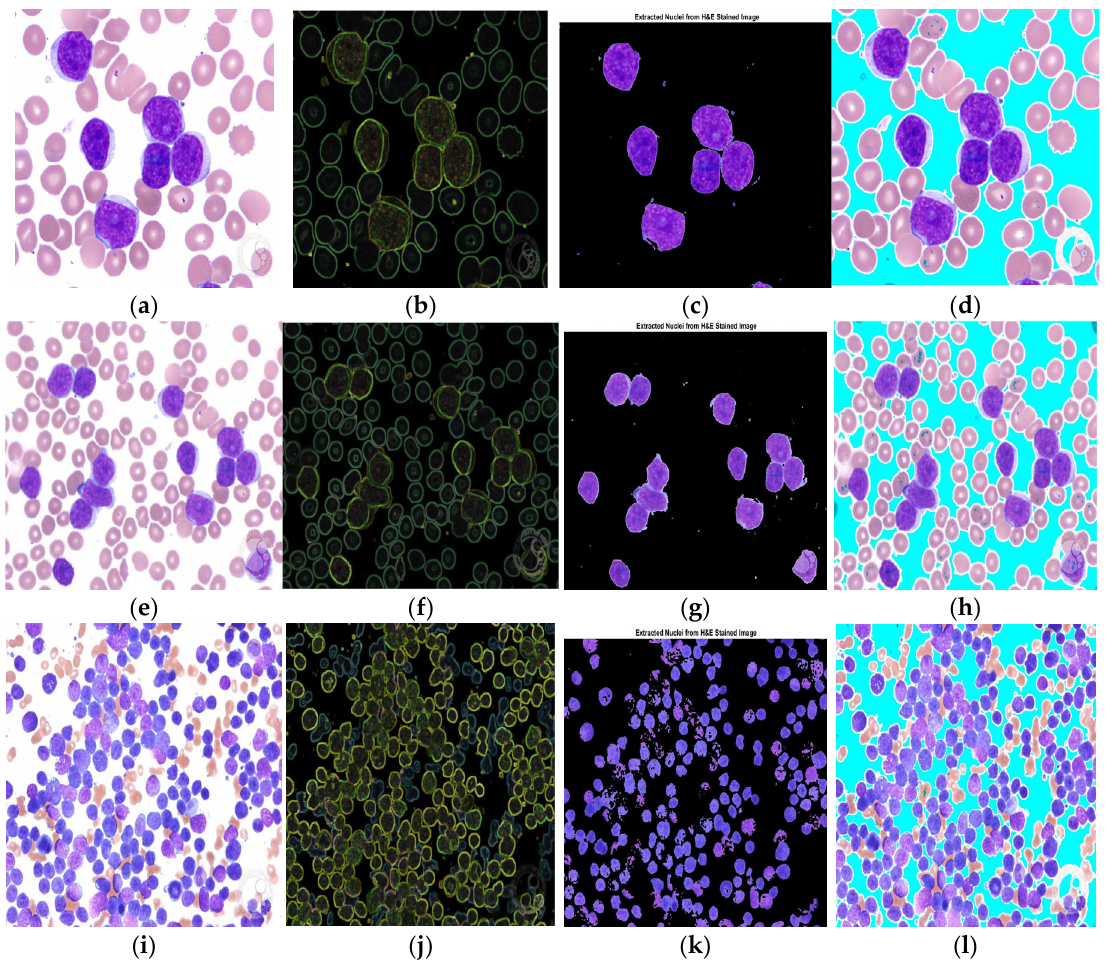
Figure 7. Output of L*a*b* projected k-means clustering (K = 3) algorithm. ( a , e , i ) Input Images ( b , f , j ) Different hue levels ( c , g , k ) Isolation of nuclei ( d , h , l ) Clustered